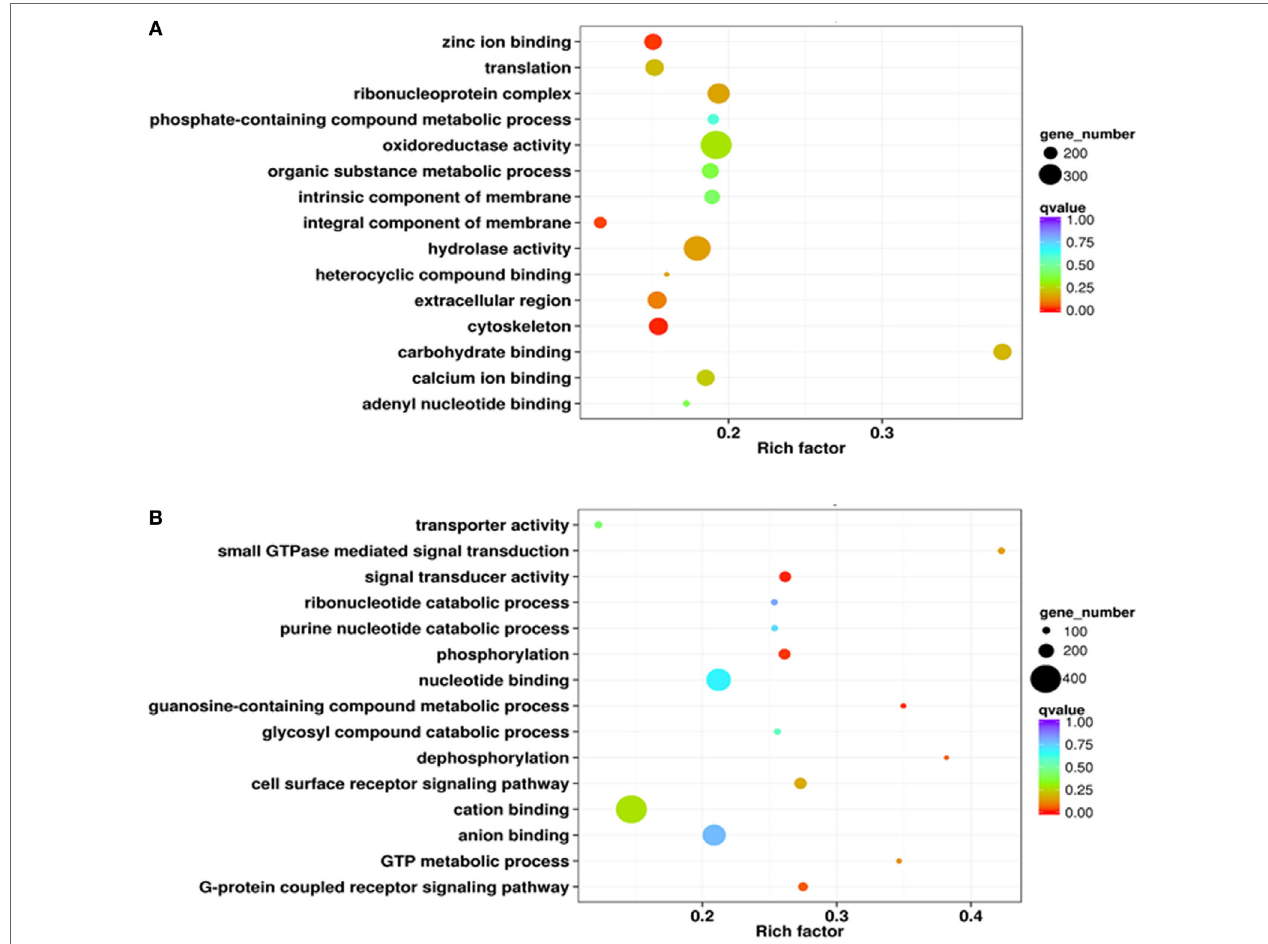
FigUre 2 | Gene ontology enrichment analysis of differentially expressed genes (DEGs) from the transcriptome. Enrichment analysis results are presented here in the form of scatterplots of high (a) and low expressed (B) phagocyte DEGs. The enrichment factor is the ratio between the DEG number and the number of all genes in a certain gene enrichment term. The sizes of the dots on these plots denote the number of DEGs, while colors correspond to the q value